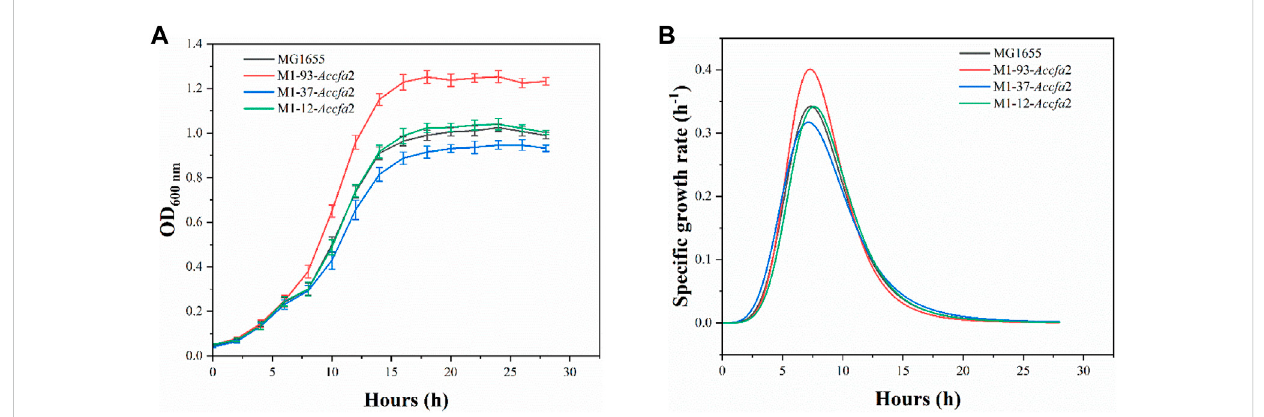
FIGURE 7 The heterologous expression of Accfa 2 enhanced the resistance of E. coli to succinic acid. (A) The growth curves of the strains MG1655, M1-93- Accfa 2, M1-37- Accfa 2 and M1-12- Accfa 2 in the presence of succinic acid at a fi nal concentration of 40 mM. (B) The speci fi c growth rate curves fi tted according to the growth curves. The error bars represented means ± standard deviations